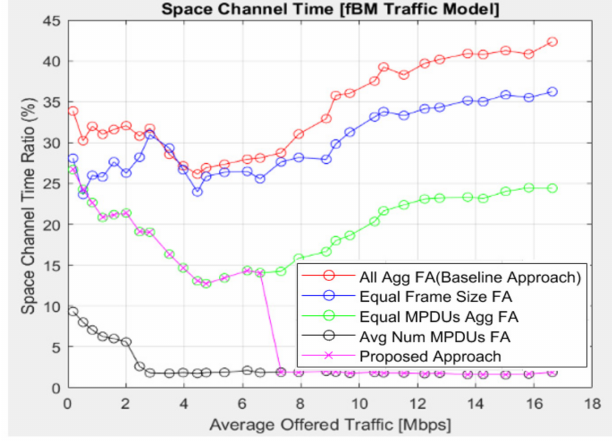
Figure 12. Performance of space channel time ratio with increasing offered traffic load using fBM traffic